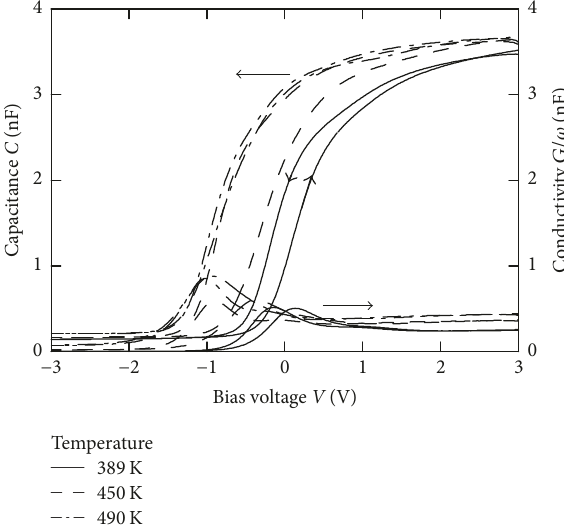
Figure 2: C-V and G-V cures of Au/Ta (5nm)/YSZ (40 nm)/ 𝑛 -Si MOS stack measured at various temperatures. Ramp voltage sweep rate 𝛽 = 0.04 V/s, measurement frequency 𝑓 = 100 kHz.